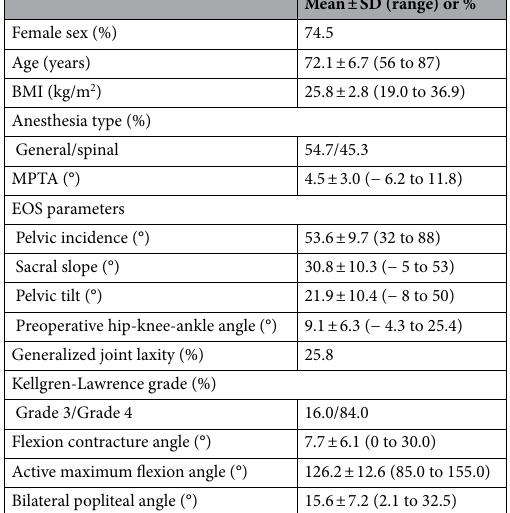
Table 1. Demographics and baseline characteristics of patients. SD standard deviation, BMI body mass index, MPTA medial proximal tibial angle, BPA bilateral popliteal angle.